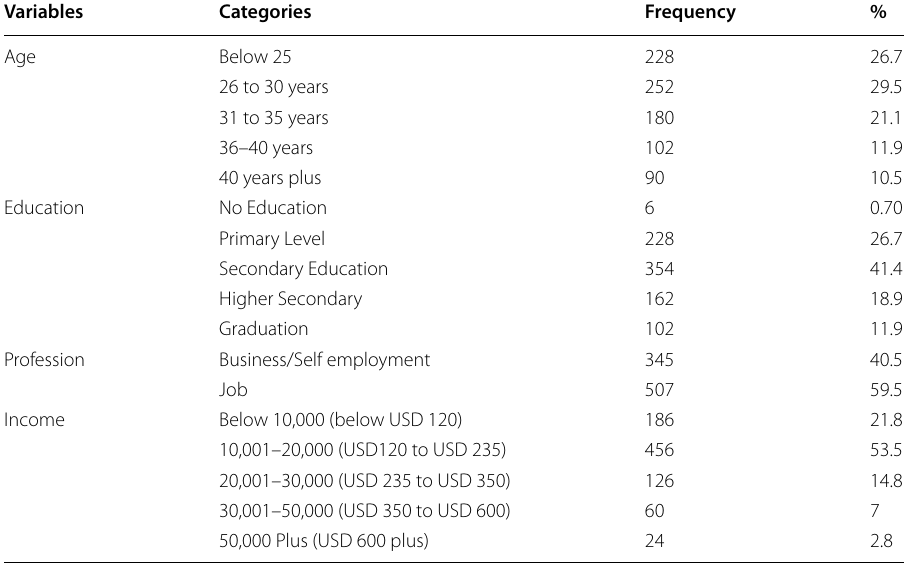
Table 1 Sample distribution. Source : Survey Questionnaire